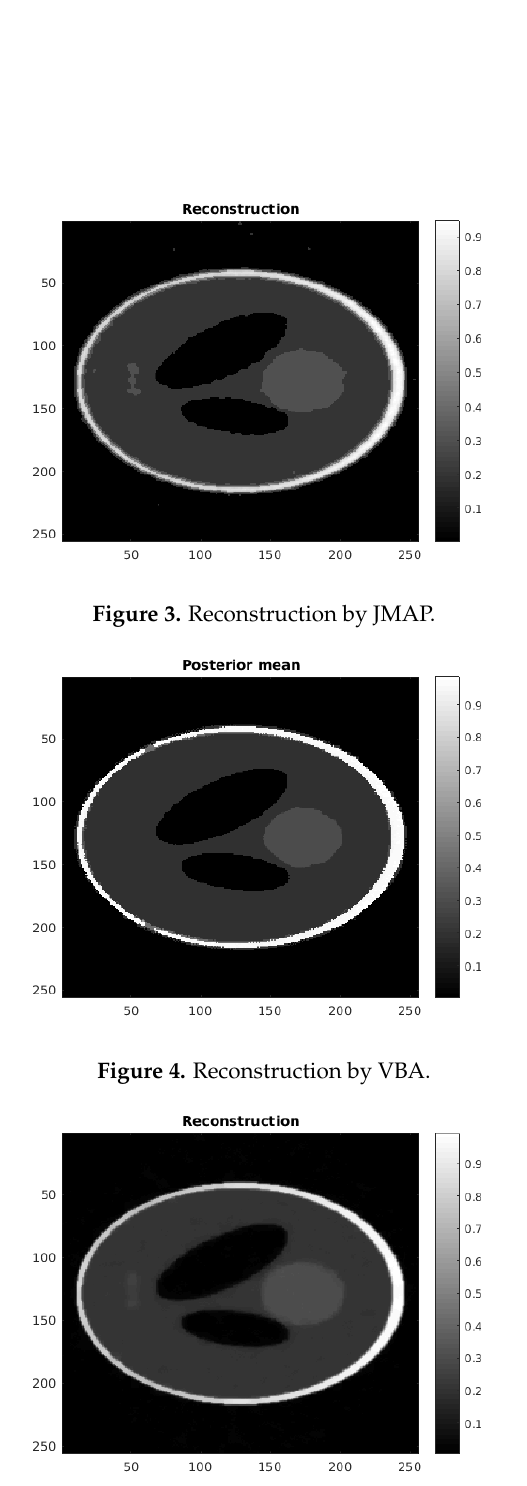
Figure 5. Reconstruction by